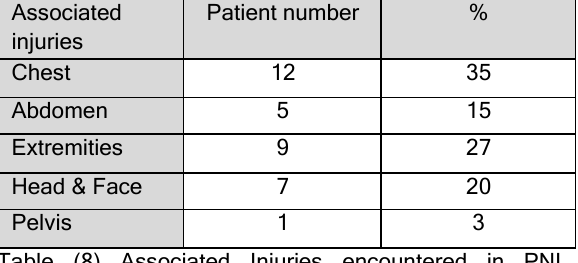
Table (8) Associated Injuries encountered in PNI